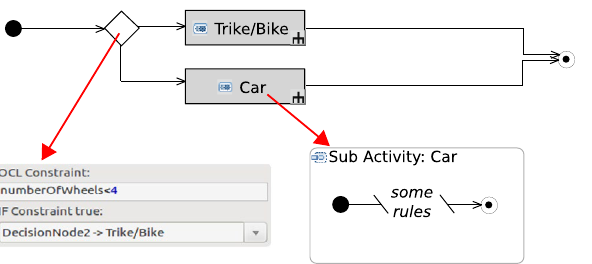
Fig. 4 Decision node for branching the rule sequence (left) based on model constraints and sub activity (right) to model hierarchi- cally embedded rule sequences